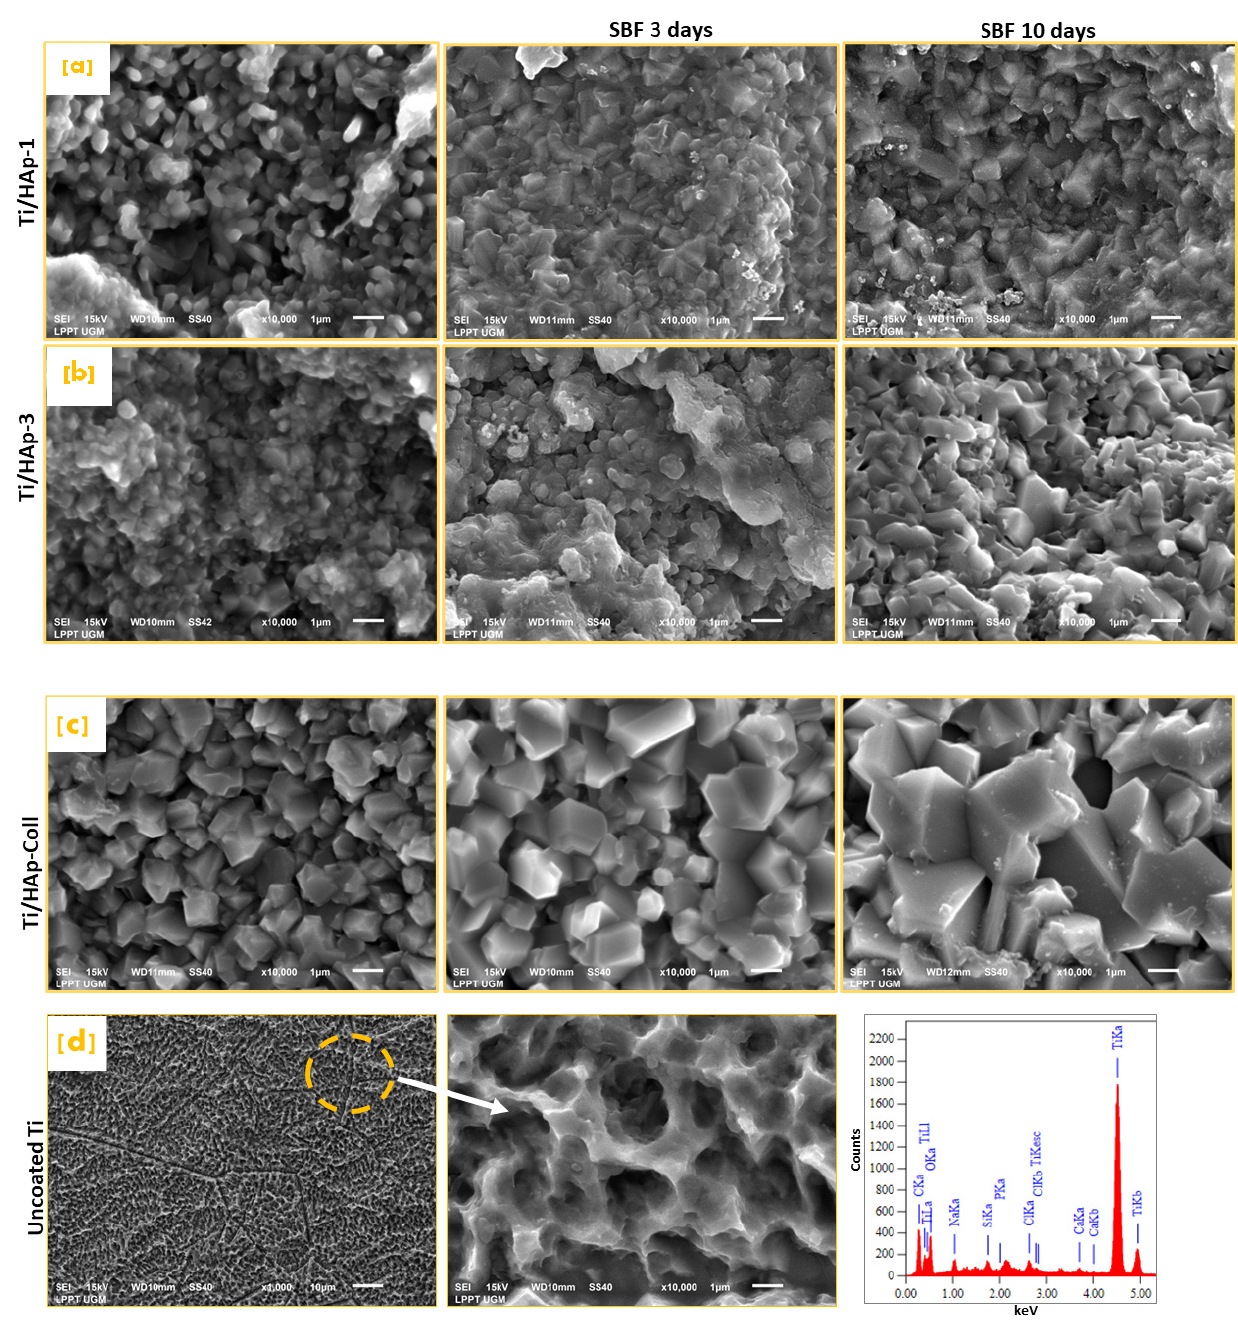
Figure 7. Surface morphology of Ti substrates before and after SBF immersion, Ti/HAp-1 ( a ); Ti/HAp-3 ( b ), Ti/HAp-coll ( c ), and uncoated Ti after 3 days SBF immersion with EDS spectra ( d